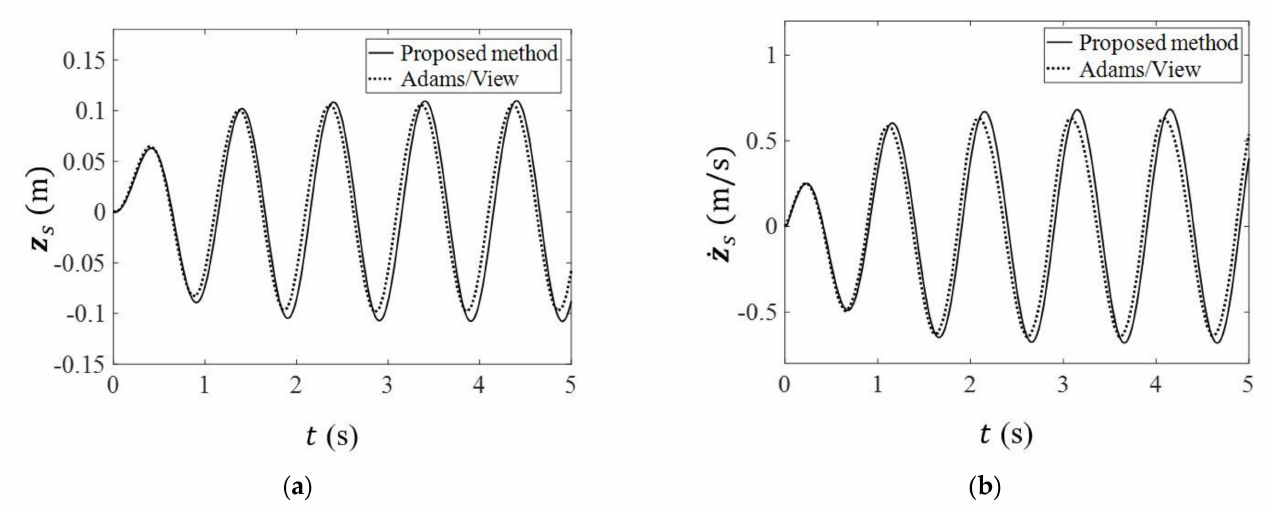
Figure 9. Sinusoidal road disturbance: z omax = 0.05 m and f = 1 Hz.